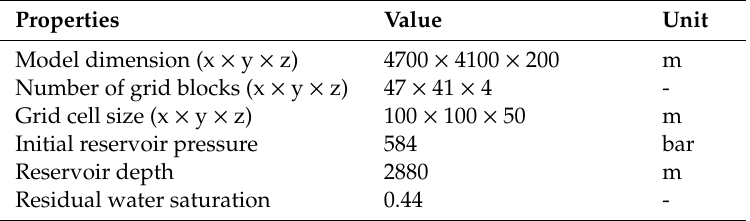
Figure 18. Five-well reservoir model for field application of water intrusion characterization. Water intrusion has been observed in wells B2, B3, and B5 (blue). Table 2. Basic reservoir properties used in the field-scale five-well group model.